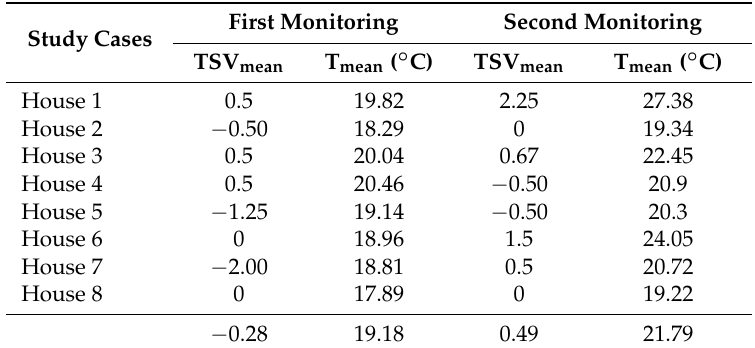
Table 3. Thermal sensation voting (TSV) and operative temperature statistics during the first and second monitoring periods.